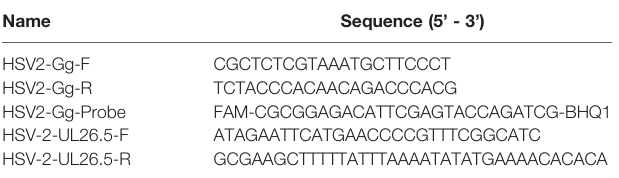
TABLE 1 | The qRT-PCR primers and ICP35 plasmid